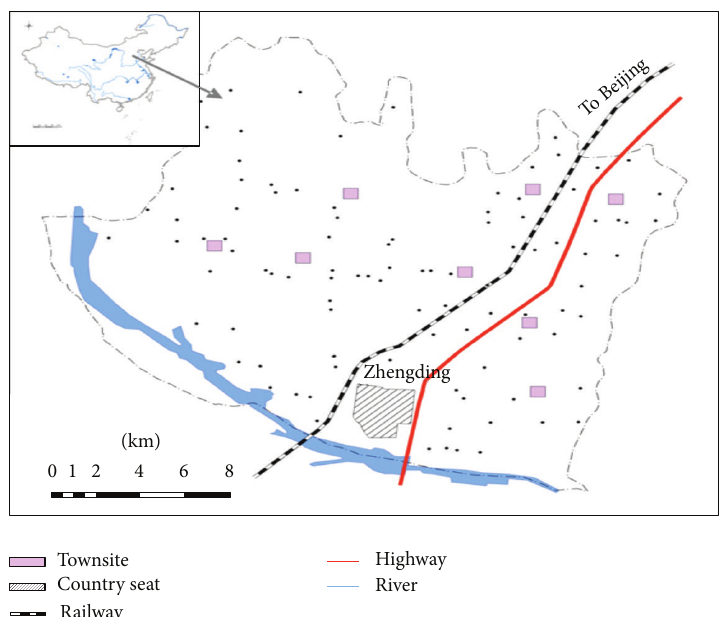
Figure 1: Map of the studied area and sampling